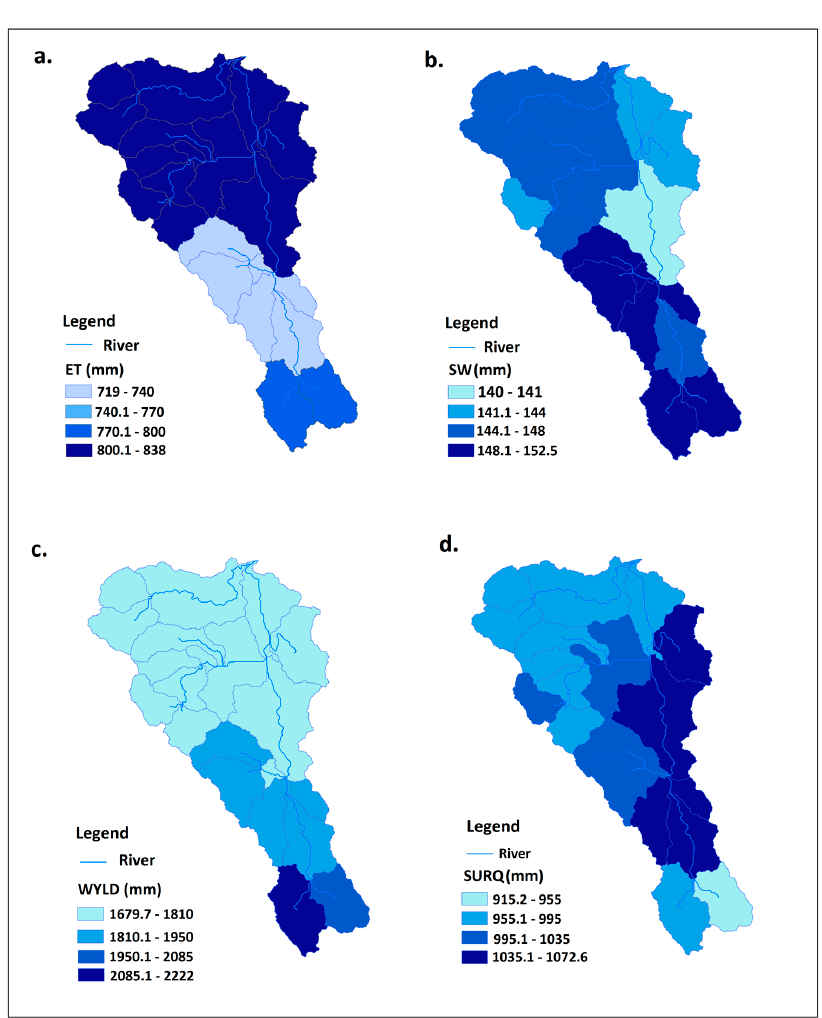
Figure 9. Spatial pattern of hydrological components in A-Luoi area: ( a ) the distribution of average annual (2005–2013) actual evapotranpiration (ETa); ( b ) soil water content (SW); ( c ) water yield (WYLD); and ( d ) surface runoff (SURQ).